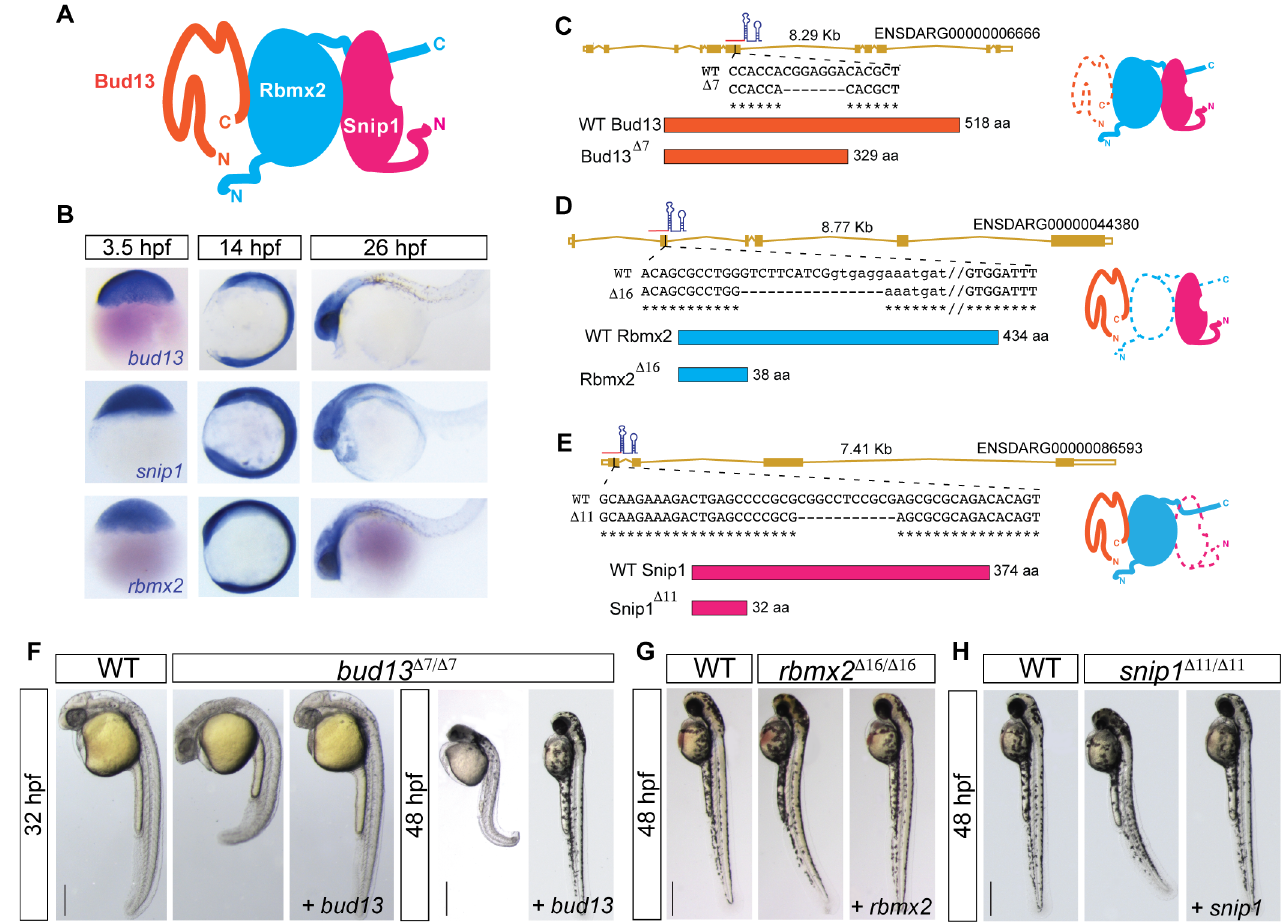
Fig 1. RES complex is essential for early vertebrate development. (A) Schematic model of the RES complex adapted from Brooks et al. [8]. Rbmx2 (light blue) is the core subunit with an RRM-domain structure. Bud13 (orange) and Snip1 (pink) interact with Rbmx2 (light blue). (B) In situ hybridization showing spatial and temporal expression of RES complex members. (C-E) Gene models of the mutant allele generated using CRISPR-Cas9-nanos. (C) bud13 , 7 nt deletion in exon 6 generated a premature stop codon. (D) rbmx2 , 16 nt deletion removed exon-intron boundary at exon 2 (exon capital letter, intron lower letter). (E) snip1 , 11 nt deletion in exon 1 generated a premature stop codon. f-g) Lateral view of RES complex mutant embryos, their corresponding WT sibling and mutants injected with the cognate mRNA. (F) bud13 mutant at 32 hpf (scale bar: 0.35mm) and at 48 hpf (scale bar: 0.5mm). (G, H) rbmx2 and snip1 mutant at 48 hpf respectively. WT: represent phenotypically wild type sibling from the same mutant fish line.